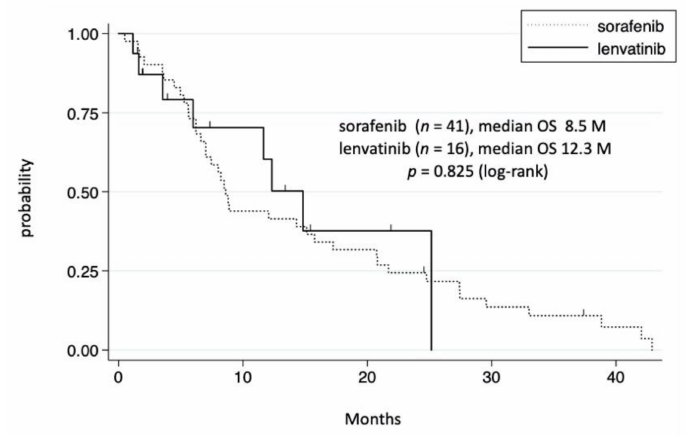
Figure 4. Cumulative survival rate of the sorafenib and lenvatinib groups. In the sorafenib group, survival rates at 1 and 3 years were 44.0% and 11.0%, respectively. In the lenvatinib group, survival rates at 1 and 3 years were 60.3% and 0%, respectively.